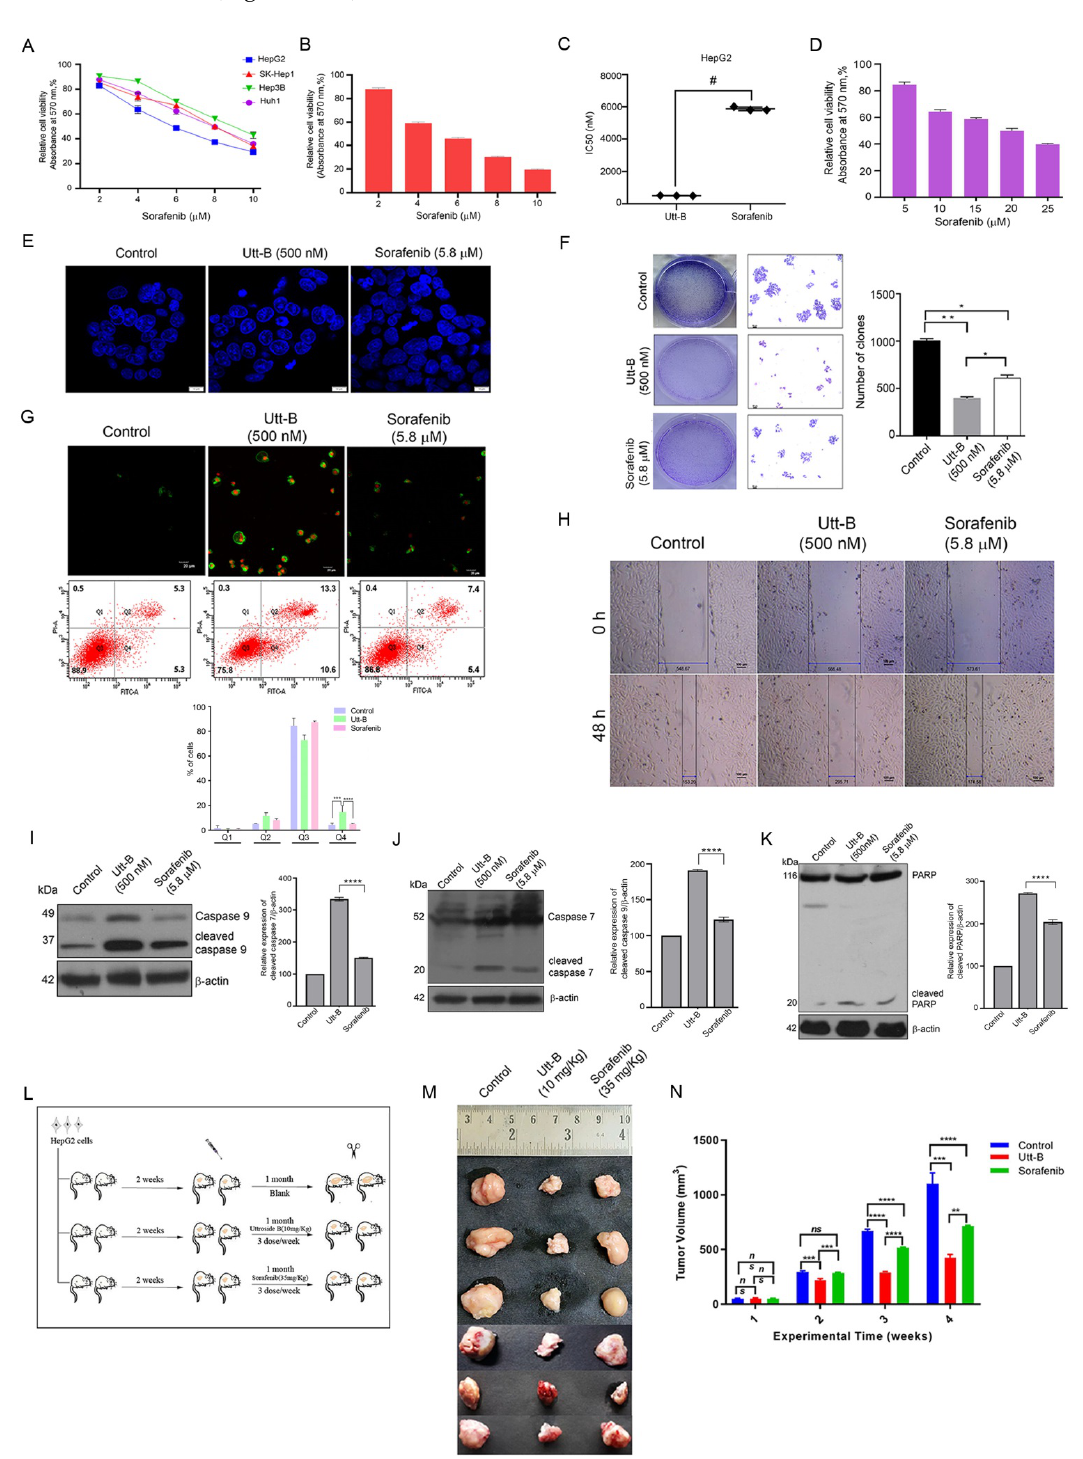
Figure 1. Utt-B triggers apoptotic mode of cell death in HCC, exhibiting better therapeutic efficacy compared to sorafenib ( A ) MTT assay of sorafenib in the indicated liver cancer cell lines. ( B ) Assessment of sorafenib cytotoxicity in HepG2 cells, as assessed by MTT Assay. ( C ) A plot between Utt-B vs.